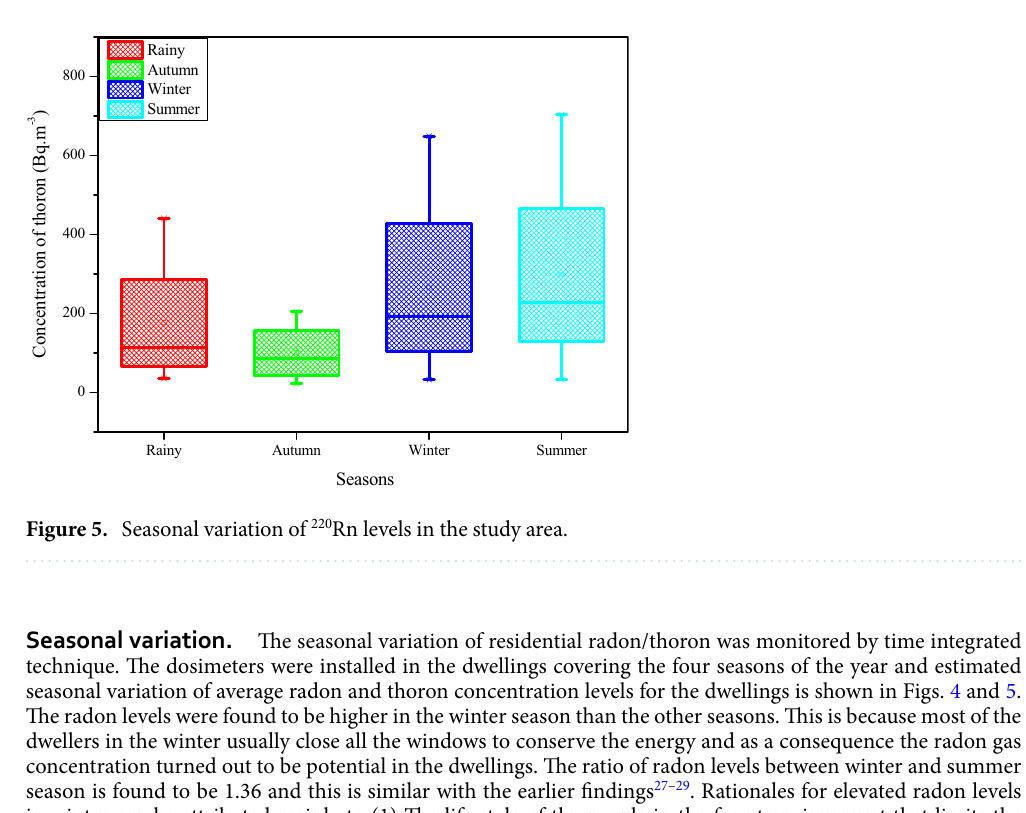
Figure 4. Seasonal variation of 222 Rn levels in the study area.